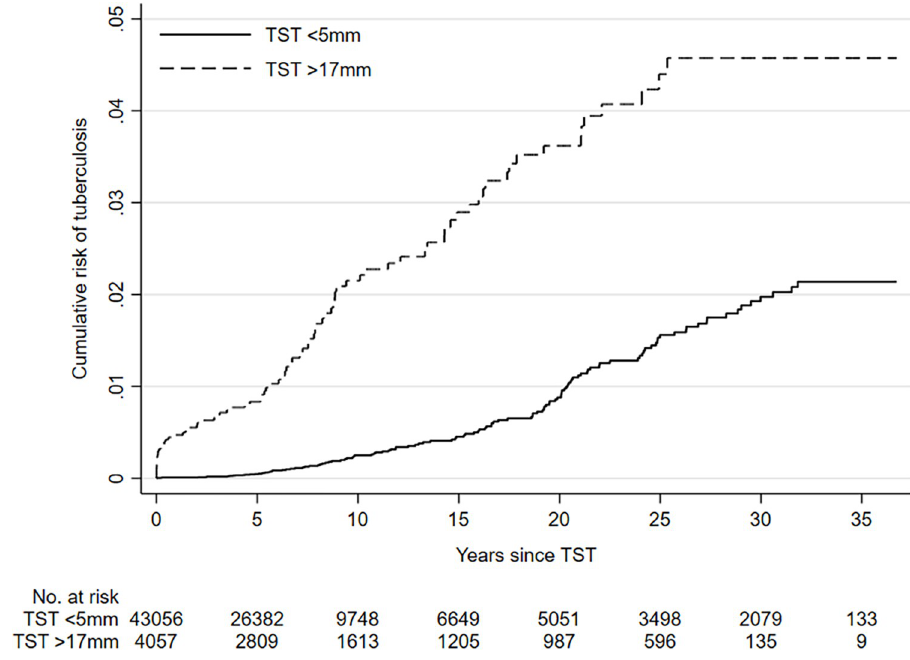
Fig 1. Cumulative risk of tuberculosis by time since tuberculin skin test, and induration size.